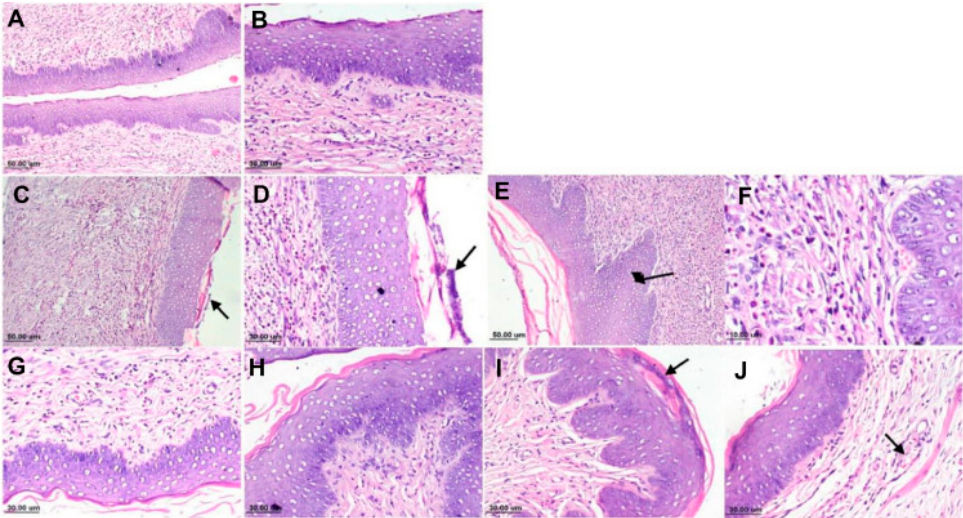
Figure 4. Photomicrograph of rat vagina, Haemotoxylin and Eosin (H&E) stain: ( A ) Negative control group, normal histology of rat normal histology of rat vagina; ( B ) negative control group, higher magnification, showing stratified squamous epithelium with dense sub-epithelial connective tissue; ( C ) positive control group, showing heavy subepithelial inflammatory cells infiltration with necrotic debris over the mucosal surface (arrow); ( D ) positive control group, higher magnification, showing dissolution of keratin layer with presence of necrotic tissue debris; ( E ) positive control group, showing hyperplastic mucosa (arrow); ( F ) positive control group, showing sub-epithelial neutrophils and mononuclear infiltration; ( G ) mucoadhesive liposomal gel group, showing mild sub-epithelial inflammatory cells infiltration; ( H ) showing intact mucosa; ( I ) sertaconazole control gel, showing mucosa with presence of necrotic debris in the keratin layer and ( J ) showing mild sub-epithelial edema with dilated blood vessels (arrow), adapted from “Formulation and Characterization of Sertaconazole Nitrate Mucoadhesive Liposomes for Vaginal Candidiasis” by Abdellatif et al.